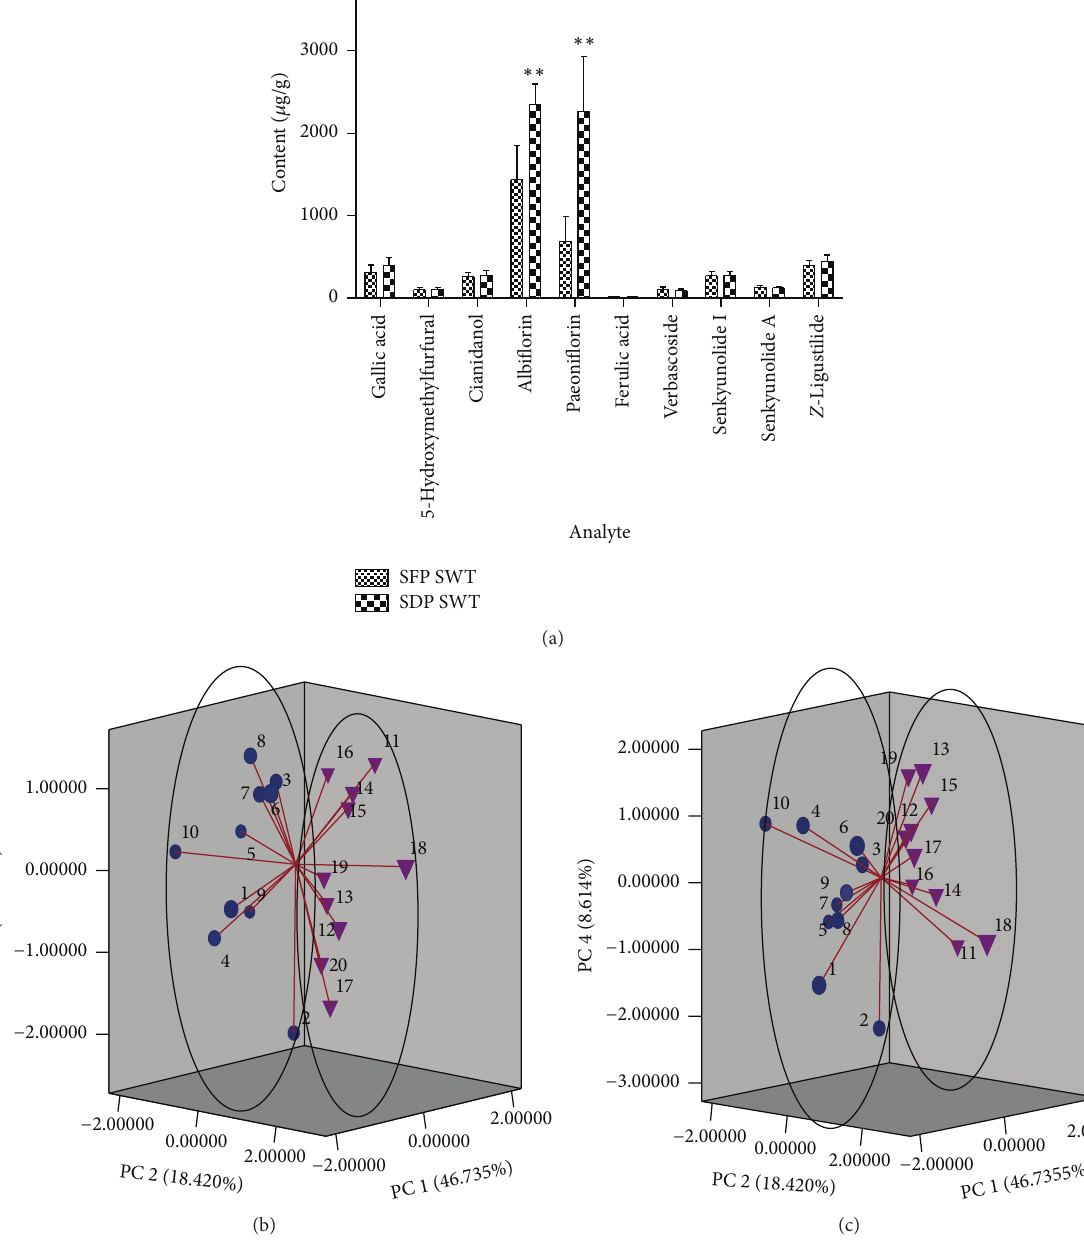
Figure 4: Column histogram statistics of content comparison ( ∗∗ 𝑃 < 0.01 ) (a), PC 1-PC 2-PC 3 score plot of PCA for twenty batches of SWT (b), and PC 1-PC 2-PC 4 score plot of PCA for twenty batches of SWT (c) (1–10, SFP SWT; 11–20, SDP